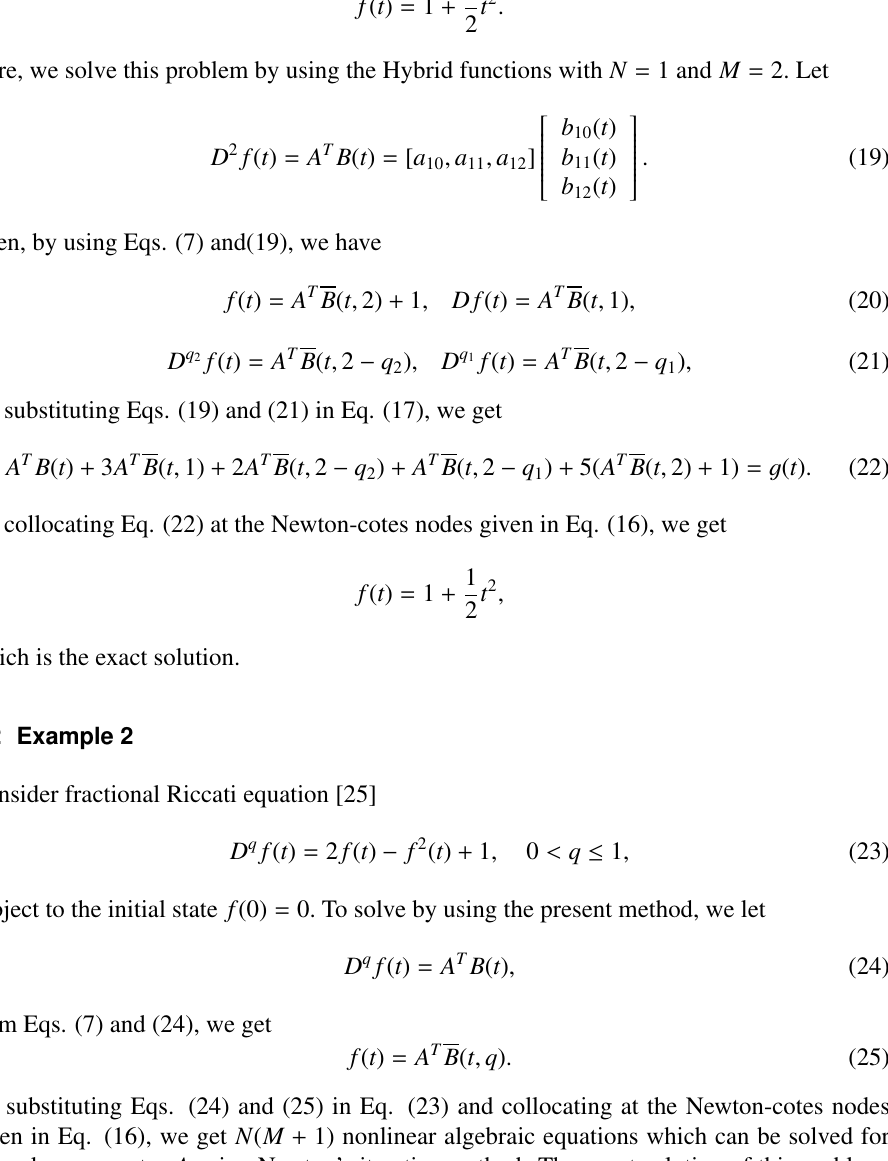
Figure 1. The approximate solutions, using the present method, are in agreement with the exact solutions for q = 1 and, as indicated in Figure 2, the solution continuously depends on the time-fractional